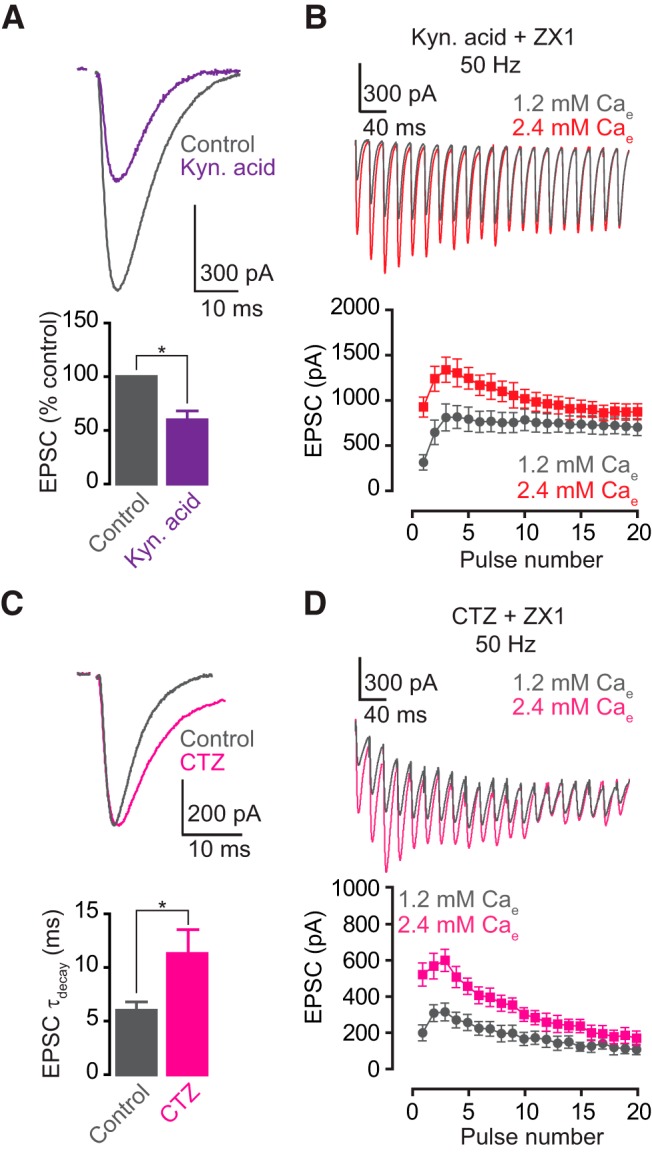
AMPAR saturation or desensitization do not contribute to the zinc-mediated enhancement of EPSCSS. A, C, Upper panels, representative traces of AMPA EPSCs before (gray) and after (color) bath application of 0.5–1 mm kynurenic acid (A) and 100 µm cyclothiazide (C). Lower panels, summary graphs showing normalized AMPA EPSC amplitude (A) and decay time constant (C), before (gray) and after (color) 0.5–1 mm kynurenic acid (A) and 100 µm cyclothiazide (C; AMPA EPSC amplitude: control vs. kynurenic acid, n = 5, p < 0.01; AMPA EPSC decay time constant: control vs. cyclothiazide, n = 5, p = 0.04). B, D, Upper panels, representative traces of AMPA EPSCs evoked by 50-Hz 20-pulse train in 1.2 mm (gray) and 2.4 mm (color) external calcium, in 0.5–1 mm kynurenic acid and ZX1 (B) or in 100 µm cyclothiazide and ZX1 (D). Lower panels, summary graphs showing average AMPA EPSC amplitudes during the train, in kynurenic acid and ZX1 (B), or in cyclothiazide and ZX1 (D). (EPSC16–20 amplitude: kynurenic acid: 1.2 vs. 2.4 mm calcium, n = 5, p = 0.13; cyclothiazide: 1.2 vs. 2.4 mm calcium, n = 5, p = 0.06.) Values represent mean ± SEM. Detailed values and statistical tests: A, lower panel: AMPA EPSC amplitude in the presence of kynurenic acid: 59.63% ± 8.5% of baseline, n = 5, p < 0.01, t = 4.74, df = 4; one-sample t-test. C, lower panel: AMPA EPSC decay time constant: control vs. cyclothiazide: 5.99 ± 0.81 vs. 11.32 ± 2.15, n = 5, p = 0.04; paired t-test, t = 2.95, df = 4. B, lower panel: EPSC16–20 amplitude: kynurenic acid: 1.2 mm calcium: 718 pA ± 94 pA vs. 2.4 mm calcium: 812 pA ± 96 pA, n = 5, p = 0.13, F = 2.37, DFn = 1, DFd = 40; two-way ANOVA. D, lower panel: cyclothiazide: 1.2 mm calcium: 122 pA ± 32 pA vs. 2.4 mm calcium: 186 pA ± 41 pA, n = 5, p = 0.06, F = 3.6, DFn = 1, DFd = 40; two-way ANOVA.